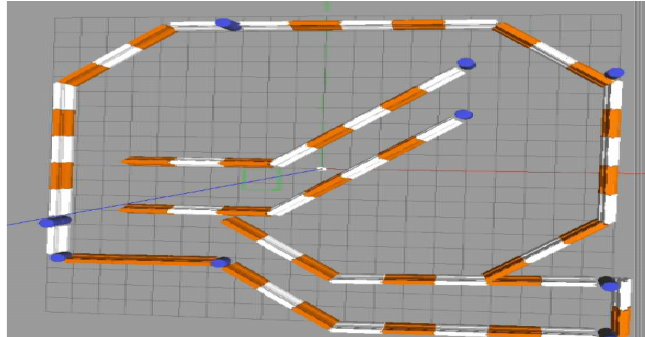
Figure 7. Narrow road.